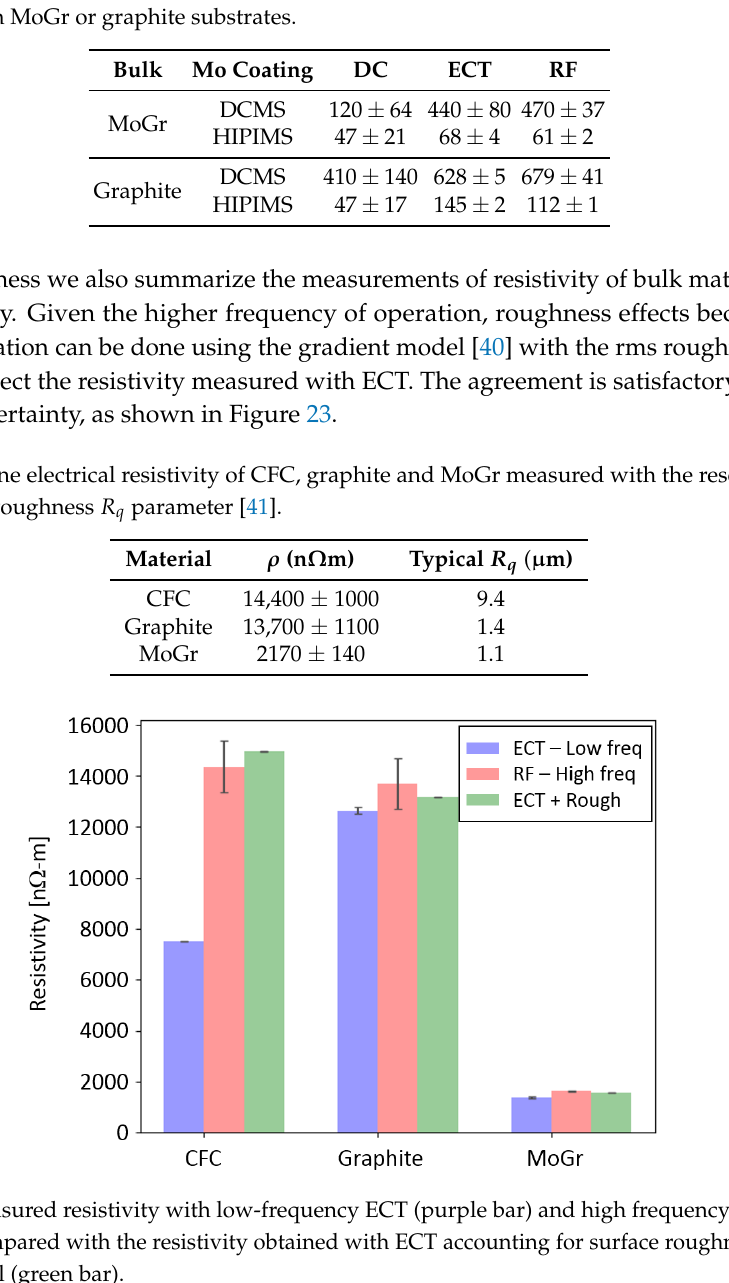
Figure 23. Measured resistivity with low-frequency ECT (purple bar) and high frequency RF (red bar) techniques compared with the resistivity obtained with ECT accounting for surface roughness with the gradient model (green